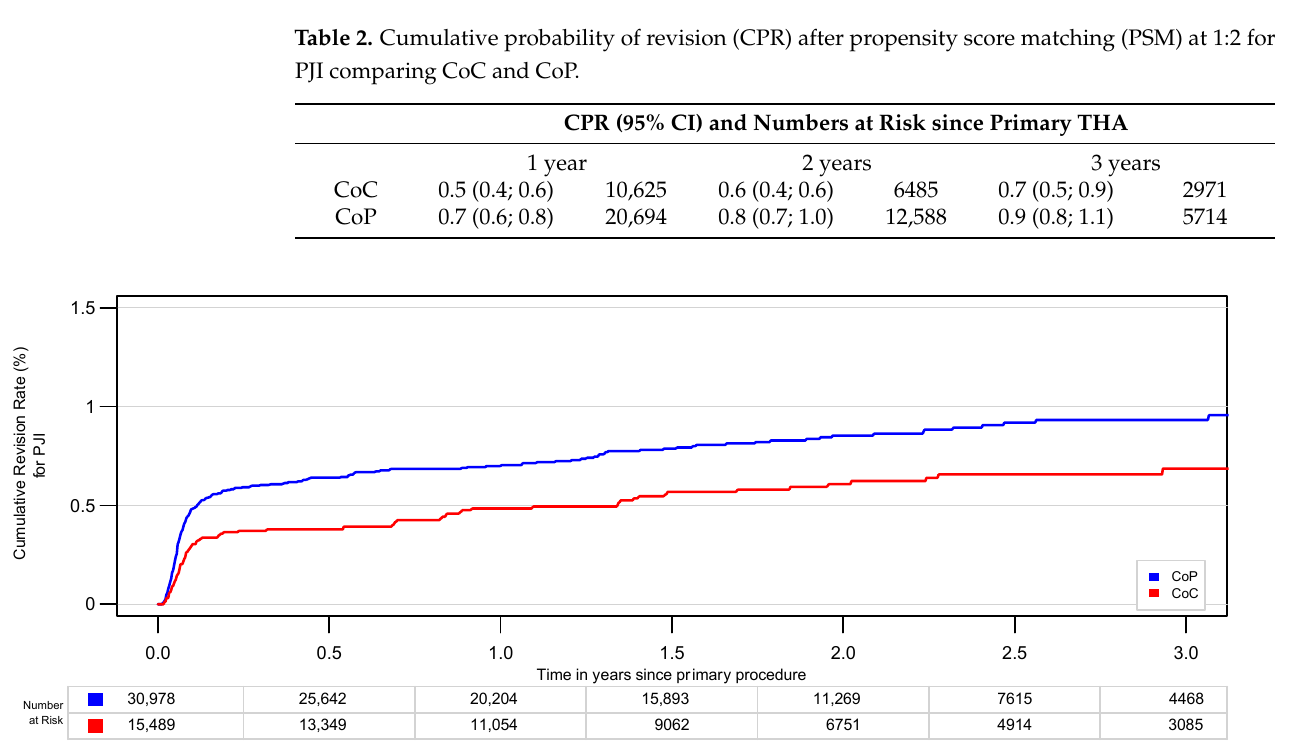
Figure 3. The cumulative risk of revision CoP and CoC bearings for PJI after PSM (2:1) is significantly different ( p = 0.008).